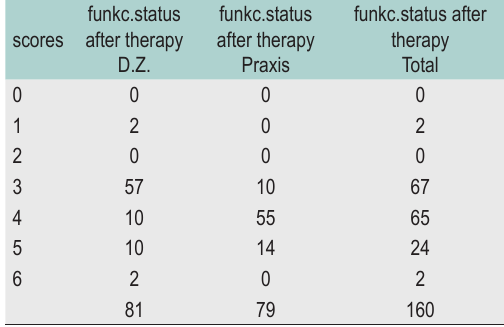
TABLE 6. Functional status before therapy in respondents with bilateral gonarthrosis in clinics D.Z. “Novi Grad” and "Praxis".